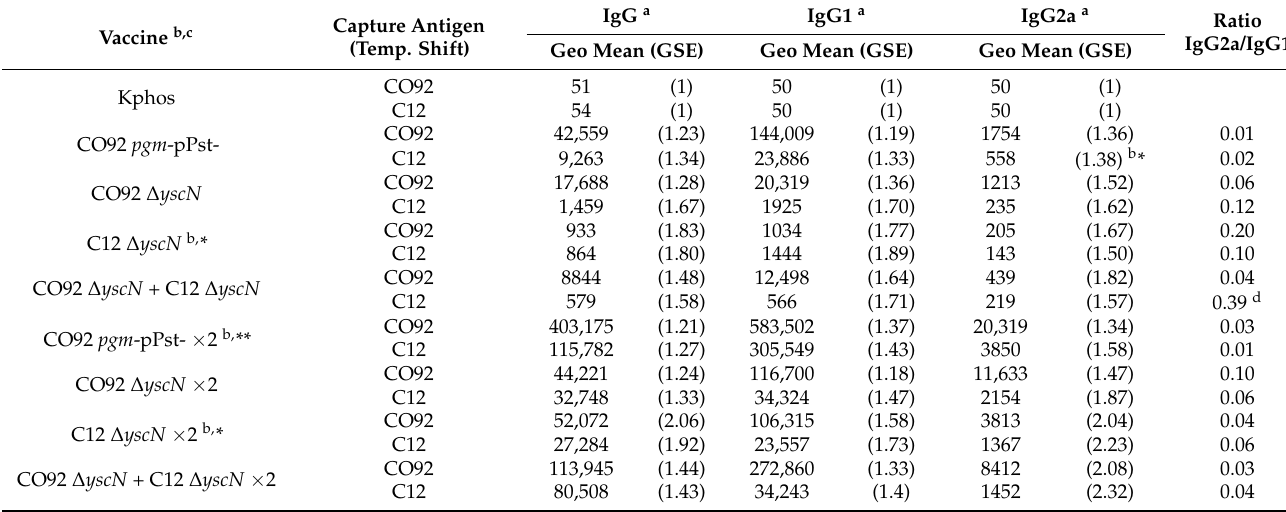
Table 9. Humoral immune responses elicited by vaccines to antigens prepared with change in temperature (30–37 ◦ C). Vaccine